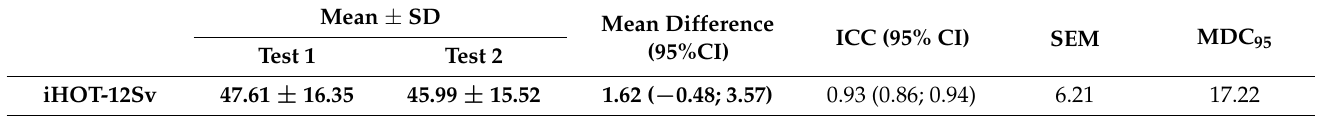
Table 3. Test–retest reliability measures of the Spanish version of the